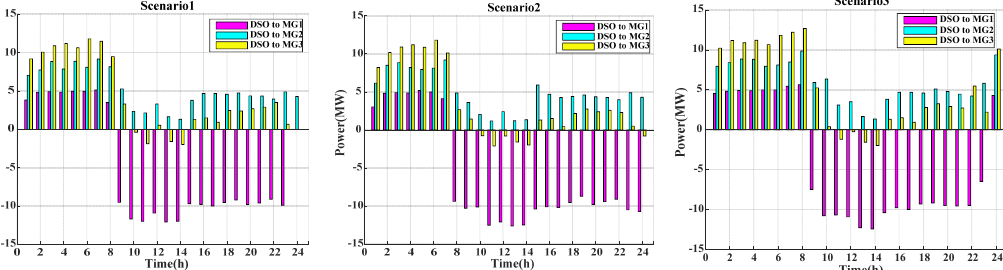
Figure 10. Exchanged power between DSO and MGs in different scenarios for CS2: ( a ) scenario 1; ( b ) scenario 2; ( c ) scenario 3.